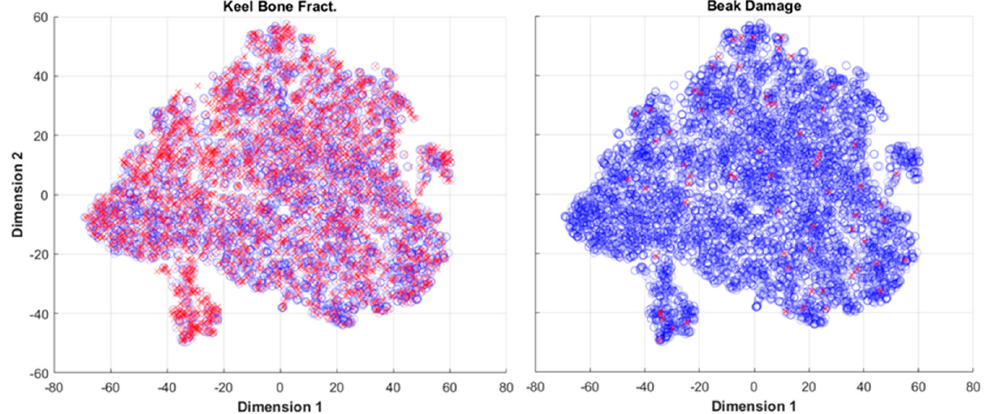
Figure 4. Two-dimensional representation of the dataset constructed using t-SNE for ( left ) the most balanced data set, keel bone damage, and ( right ) least balanced dataset, the beak damage, response with the minority class point denoted with red crosses and majority class points designated with blue circles.